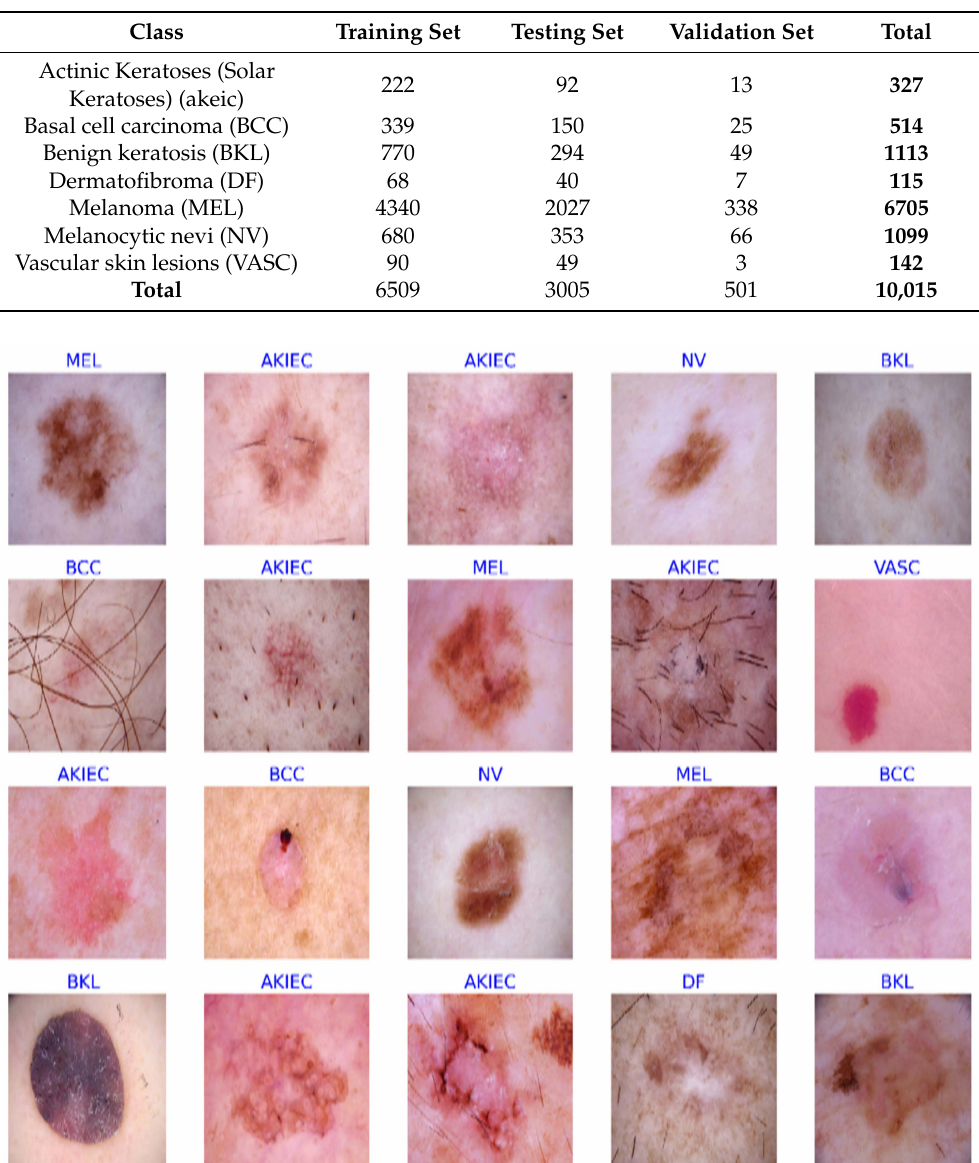
Table 1. Class distribution in the HAM10000 dataset.